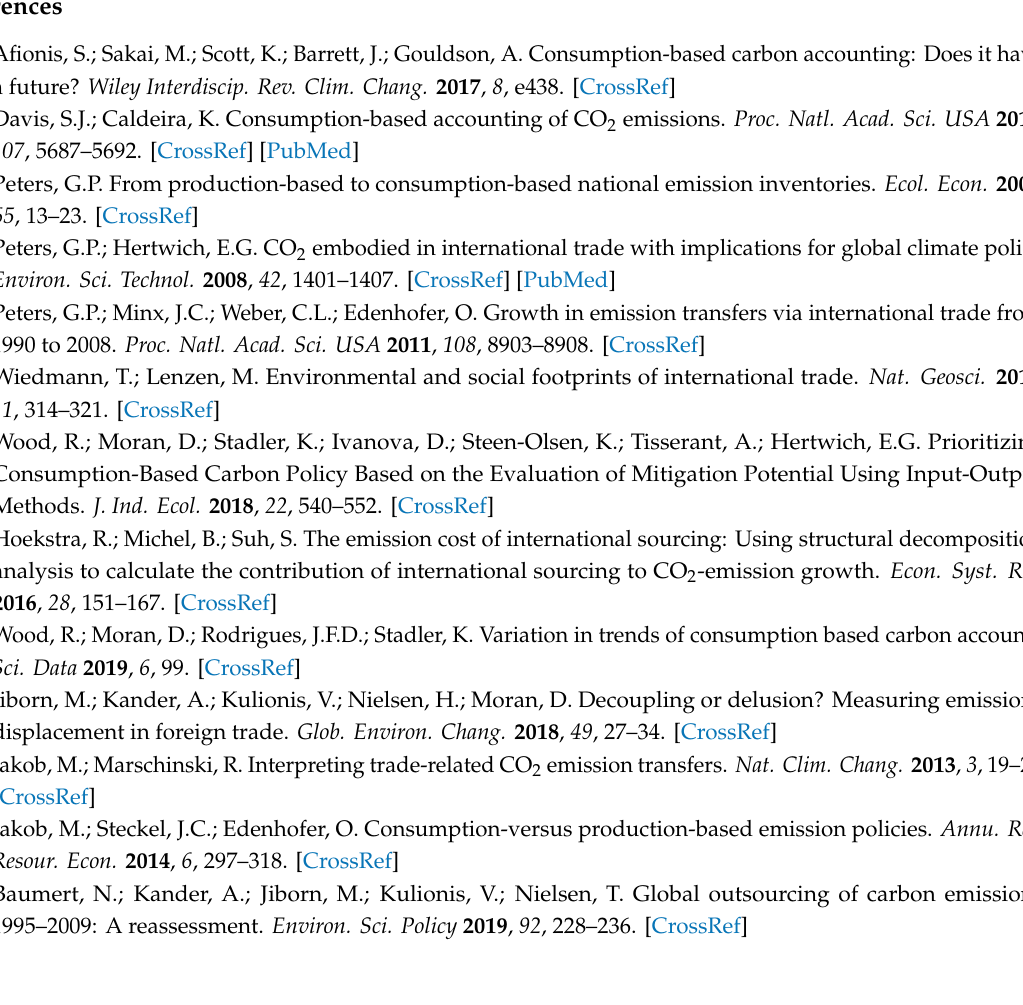
Table S1: Drivers of change in emissions